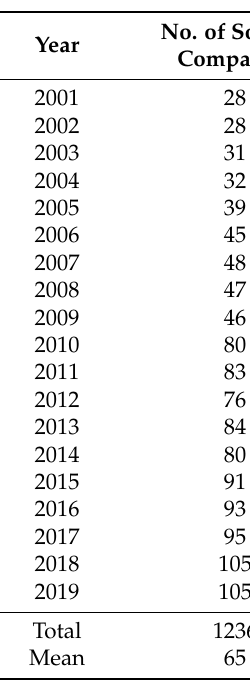
Table 1. Annual numbers of solvent and insolvent